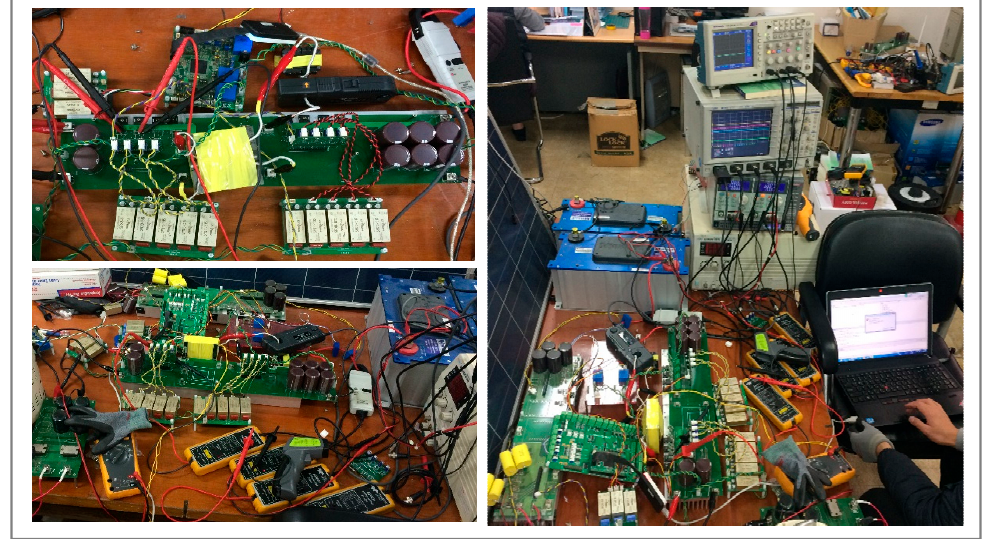
Figure 5. Developed DAB-IBDC converter and experimental setup.